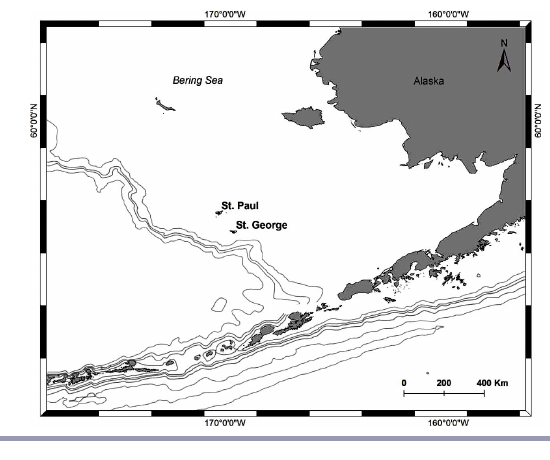
Fig. 1 . Map of study locations in the Bering Sea. The Pribilof Islands with the communities St. Paul and St. George